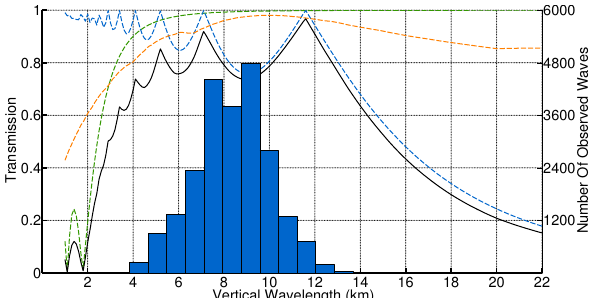
Figure 6. Transmission against vertical wavelength for each step in our Wave-ID processing for synthetic waves with λ Z < 22km centred at 30km altitude: background subtraction (blue dashed), noise reduction (green dashed), Gaussian windowing and CWT (or- ange dashed) and the combined transmission (black solid). Blue bars show a histogram (right axis) of number of waves identified in COSMIC data in the region 35–75 ◦ S, 0–90 ◦ W during June– August 2006–2012 using this